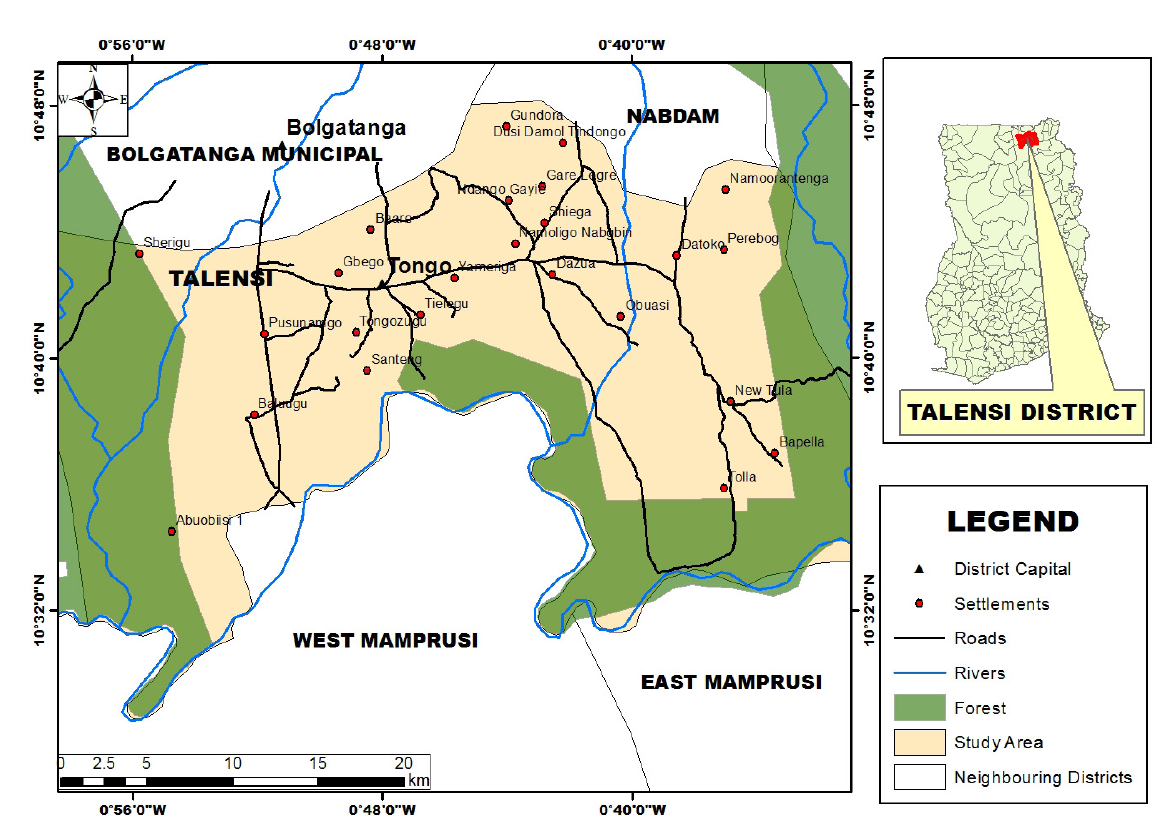
Figure 1: Map of Talensi District. Source: